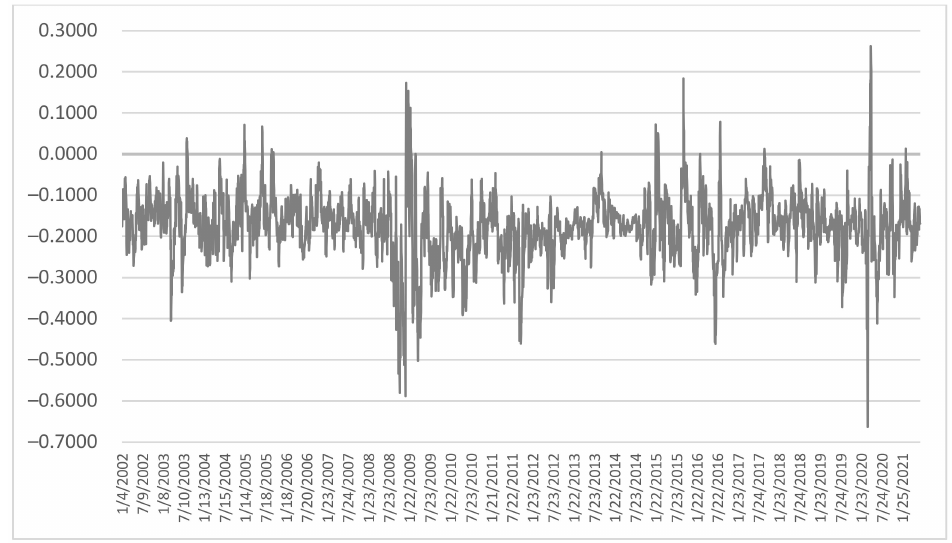
Figure 1. Estimation of the dynamic conditional correlation from model DCC(1,1) GARCH with the multivariate Student’s-t errors, between WTIF and NBUSBIS.